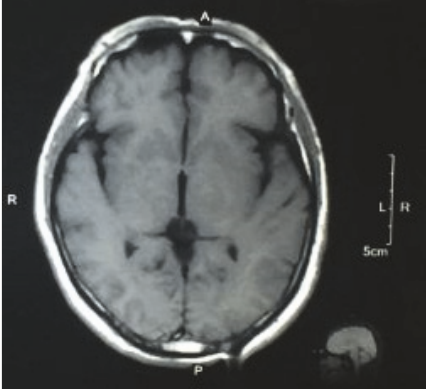
Figure 2: Magnetic resonance imaging of the brain; axial section of the brain is shown. The image shows normal study of the